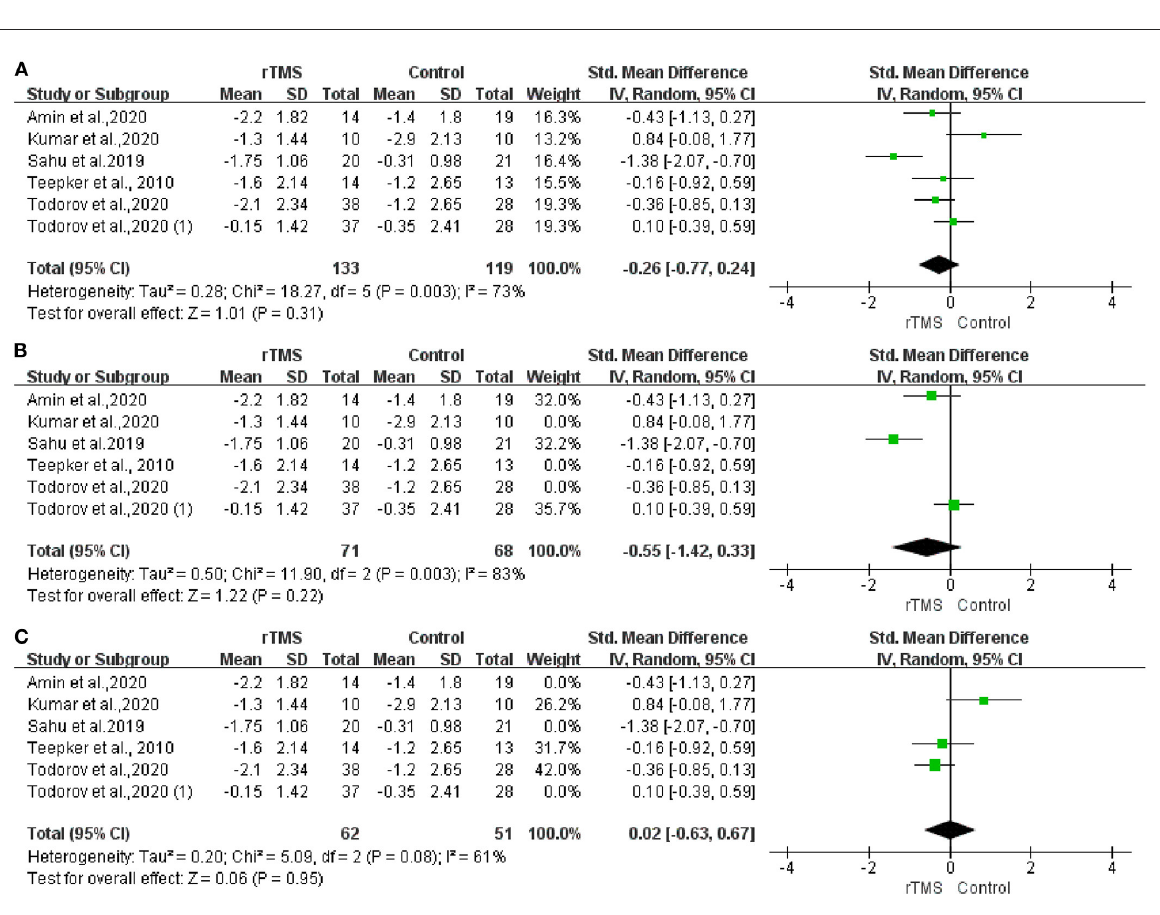
FIGURE3 Forest plot of pain intensity. (A) LDLPFC/motor cortex stimulation. (B) LDLPFC stimulation. (C) Motor cortex